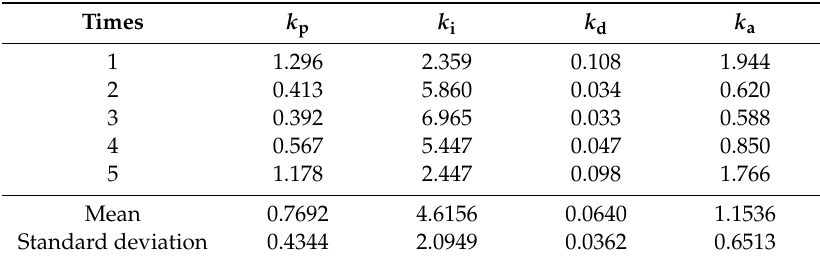
Table 2. Optimized controller parameters of desuperheater controller B.